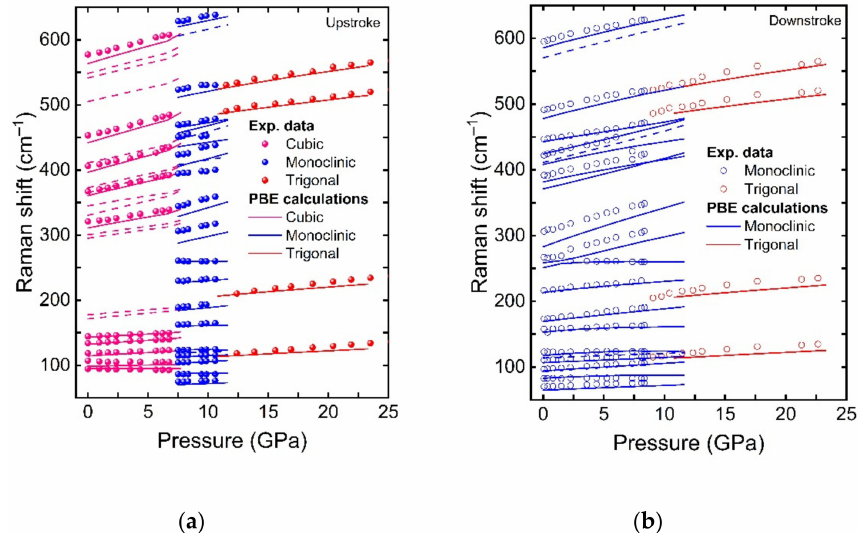
Figure 1. Pressure dependence of the experimental (symbols) and theoretical (lines) Raman-active frequencies in cubic, monoclinic, and trigonal Tb 2 O 3 during upstroke ( a ) and downstroke ( b ). Solid (dashed) lines correspond to experimentally observed (non-observed) Raman-active